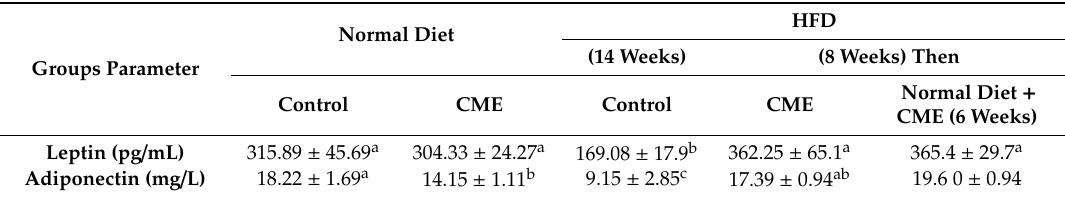
Table 7. E ff ect of HFD and / or Commiphora myrrha resin extract on Serum levels of leptin and adiponectin of rats after 14